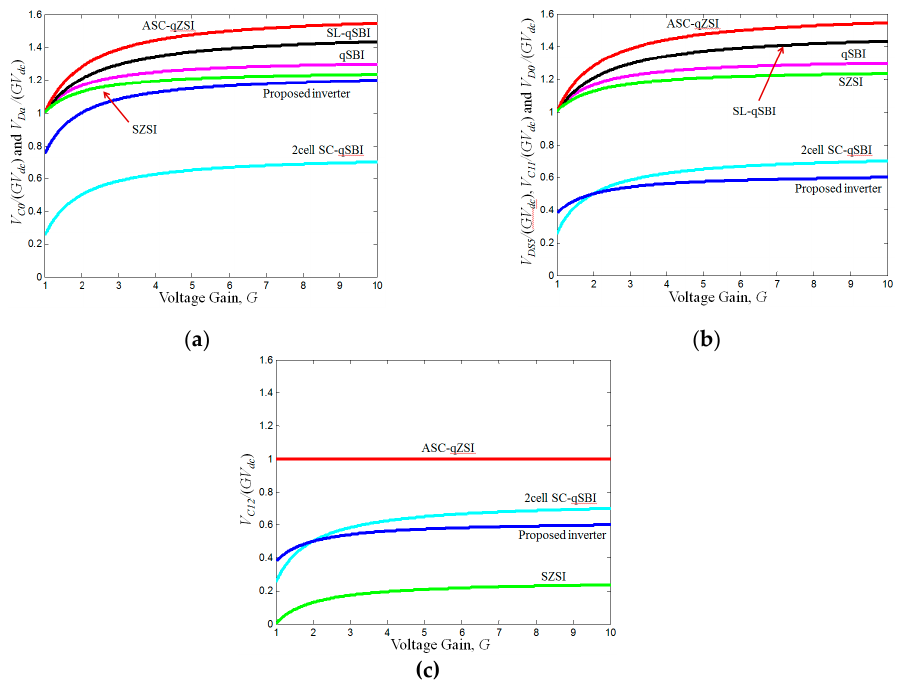
Figure 4. Voltage stress comparison. ( a ) Voltage stress on capacitor C 0 and diode D a , ( b ) voltage stress on switch S 5 , capacitor C 11 , and diode D 0 , and ( c ) capacitor C 12 voltage stress.